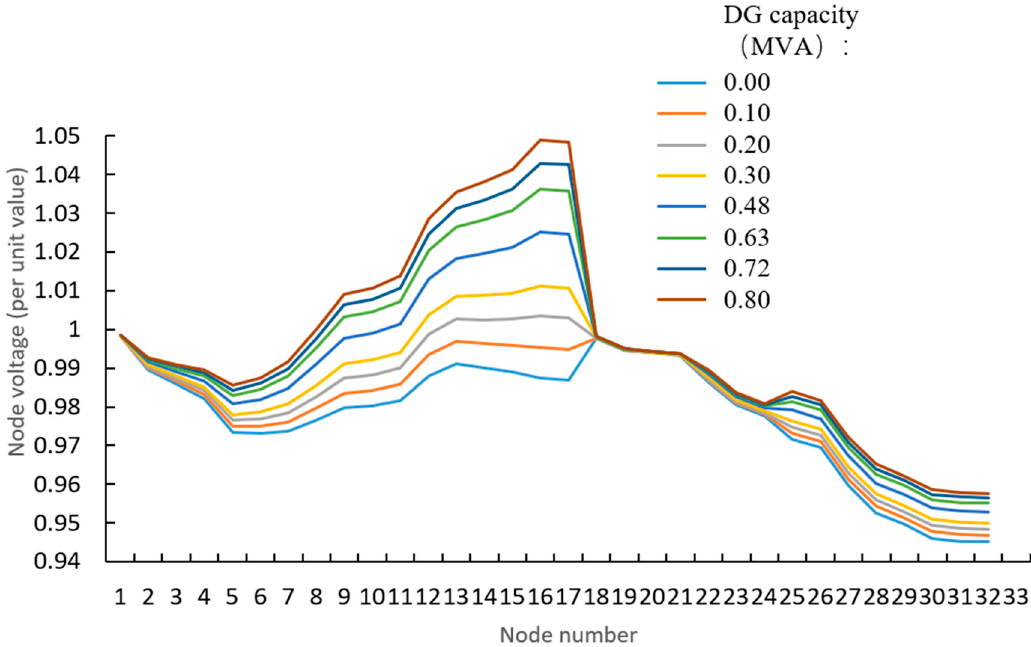
Figure 5. Voltage variation in Network 2 under different outputs of DG.